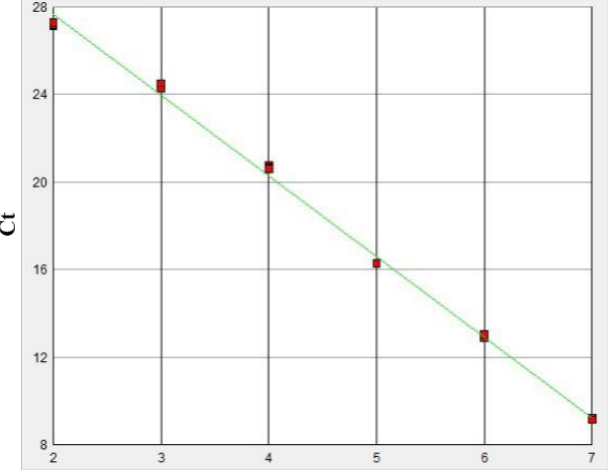
Figure 4. The standard curve obtained for the quantitation of purified TMV. The plot indicates the correlation between the Ct values and the log of the TMV particle units (Log GU). The equation of the regression line shown is y = −0.37x + 34.97; R 2 =